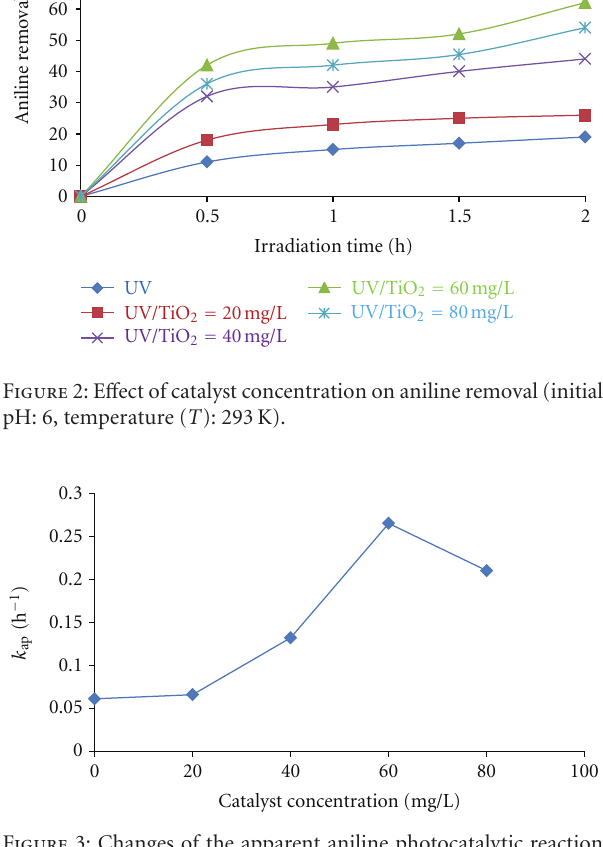
Figure 3: Changes of the apparent aniline photocatalytic reaction constant K ap at di ff erent catalyst concentration (initial pH: 6, temperature ( T ): 293K, and irradiation time: 2h). Table 2: E ff ect of catalyst concentration on photocatalytic degra- dation of aniline under UV illumination in HCBR